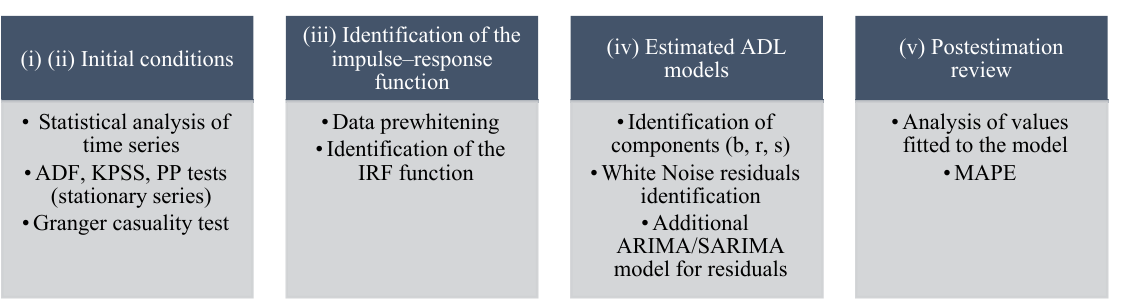
Figure 1. Process to estimate ADL models.